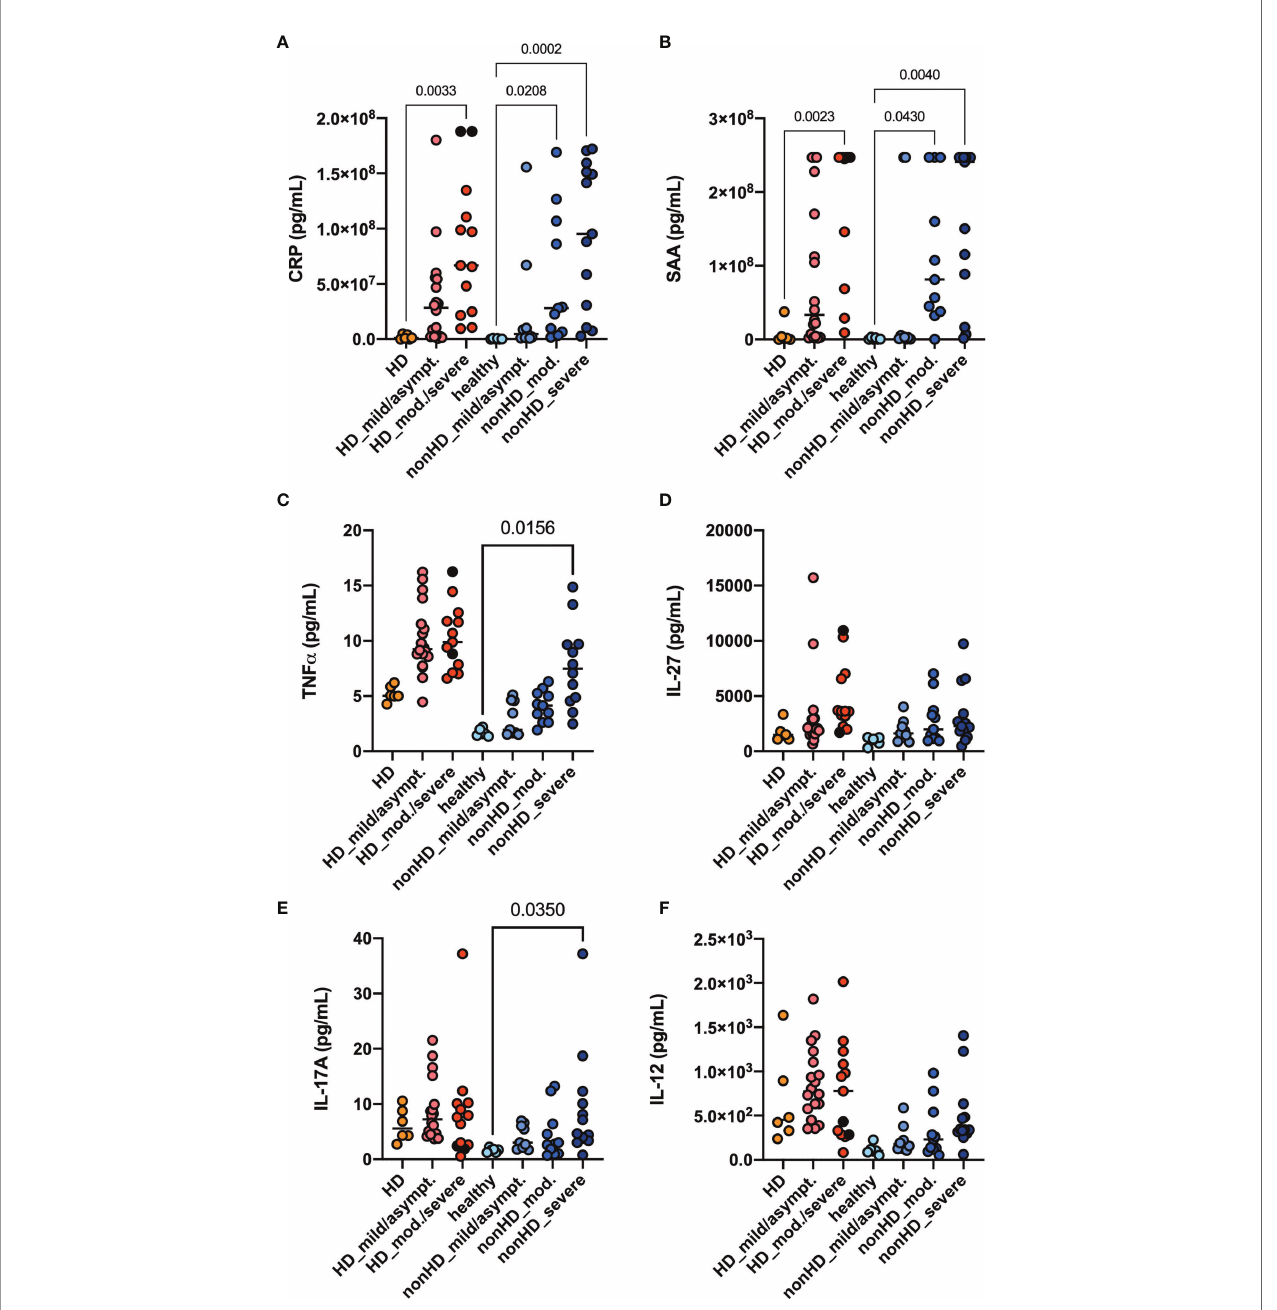
FIGURE 1 | Acute phase parameters, Th1 and Th17 plasma cytokine levels. HD- and non-HD patients without SARS-CoV-2 infection (orange circles, HD: n = 6; light blue circles, non-HD: 6), with mild/asymptomatic (light red circles, HD: n = 18; mid blue circles, non-HD: n = 9), moderate (red circles, HD: n = 11; blue circles, non-HD: n = 11) and severe COVID-19 (black circles, HD: n = 2; dark blue circles, non-HD: n = 13) were included. Severe and moderate COVID-19 HD patients were analyzed as one group. Plasma-levels of the acute phase parameters (A) CRP and (B) serum amyloid A (SAA) as well as the cytokines (C) TNF a , (D) IL - 27, (E) IL - 17A and (F) IL - 12 were evaluated. Data are shown as individual values as well as median. Only signi fi cances within the HD or non-HD collective are